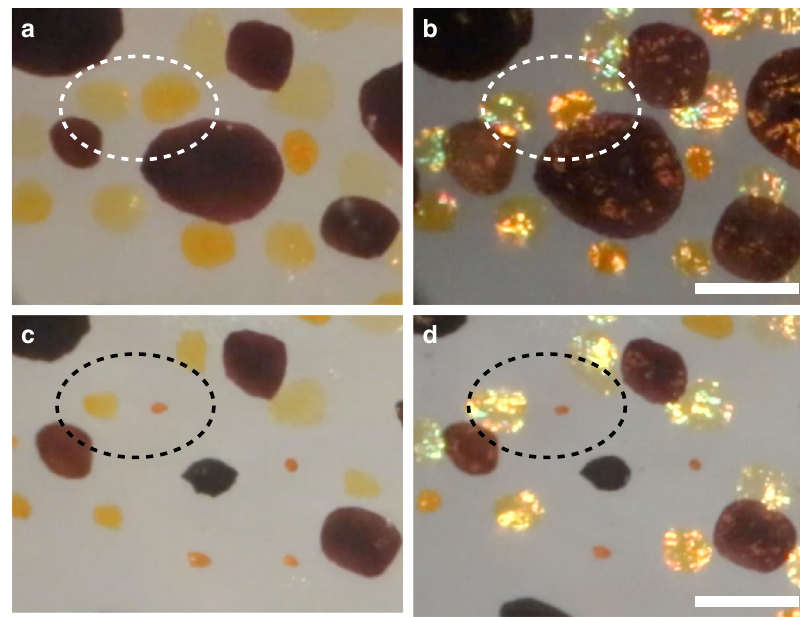
Fig. 2 Specular re fl ection from chromatophores. Still images collected from dynamic Movies of intact adult squid skin through a dissecting microscope using a movable light-pipe illuminator showing that specular re fl ection from chromatophores requires both speci fi c illumination conditions and expansion of the chromatophores. a A subset of chromatophores (white dotted circles) in expanded con fi gurations with off-axis illumination, where perceived color is attributed to pigment absorption and scattering; and b moments later, the same expanded chromatophores showing strong specular re fl ections (interpreted as structural coloration) that are seen restricted precisely to regions within each chromatophore. Only the angle of illumination was changed. When the same chromatophores are captured before c and after d actuation (black dotted circles), coloration varies depending on the angle of illumination, where there is intense specular re fl ectance for the expanded chromatophores but not for the compacted ones. (Movie frame time points all in seconds are as follows: A = 35 and B = 38, C = 4, and D = 10). Scale bars are 1